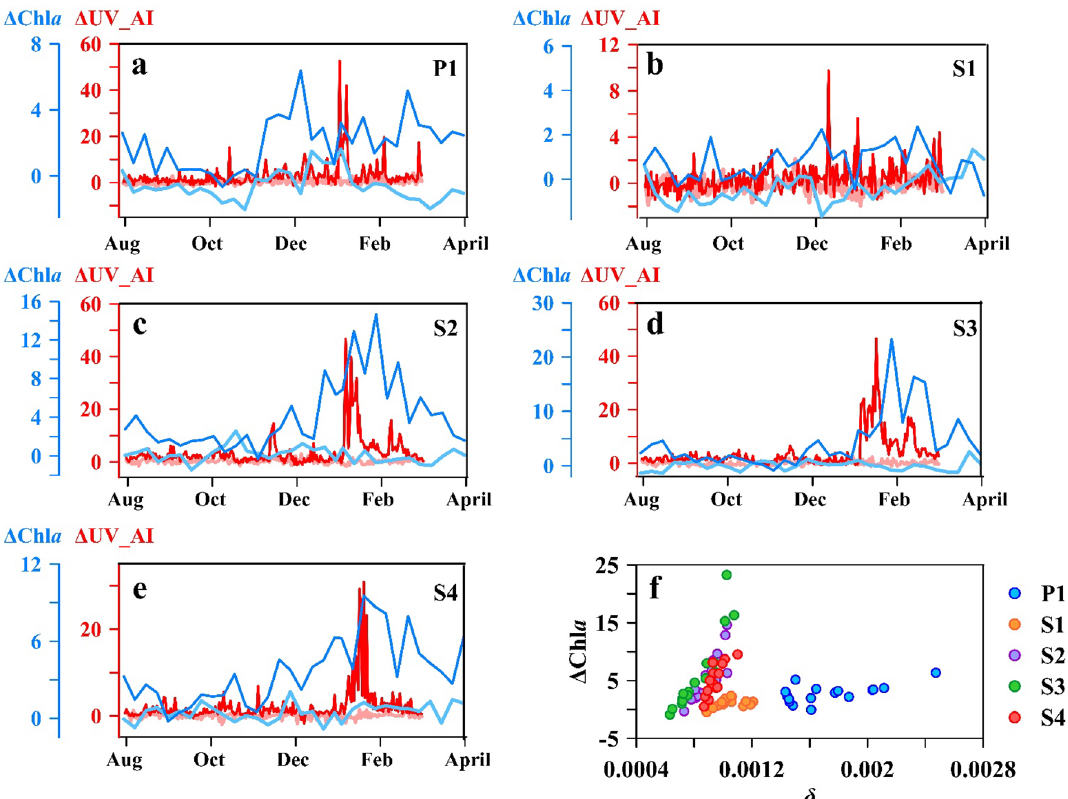
Figure 6. ( a – e ) ΔChl a and ΔUVAI data from P1 to S4. ( f ) relationship between δ and ΔChl a from 1 November 2019 to 26 February 2020. Light red and blue lines represented the ΔUVAI and ΔChla in the 2014–2015 non-fire season, respectively. Red and blue lines represented the ΔUVAI and ΔChla in the 2019–2020 bushfire season, respectively. Areas of interest from P1 to S4 are shown in Fig.